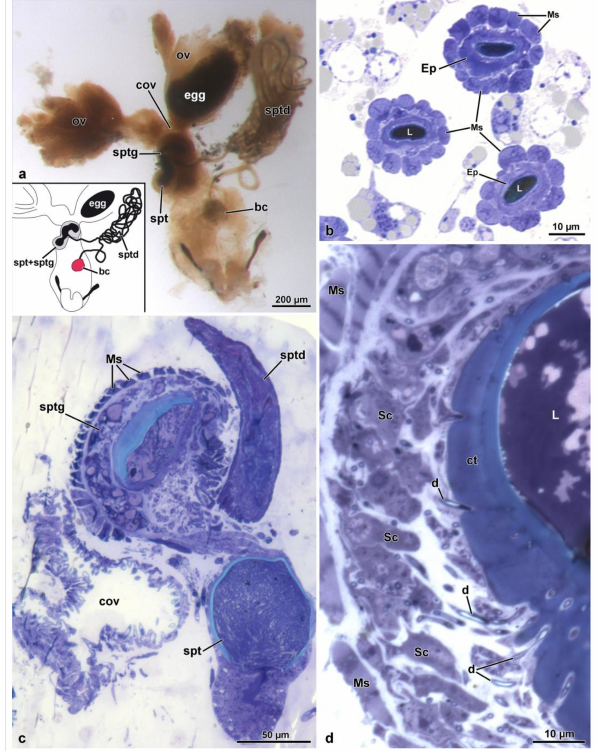
Figure 1. ( a ). Light microscopic view of the female reproductive organs. bc, bursa copulatrix; cov, common oviduct; ov, oviduct; spt, spermatheca; sptd, spermathecal duct; sptg, spermathecal gland. Egg at the end of the oviduct. ( b ). Semi-thin section through the spermathecal duct showing the thick layer of muscle cells (Ms) and the epithelium (Ep). L, duct lumen. ( c ). Semi-thin section of the complex spermatheca (spt)–spermathecal gland (sptg). Note the spermathecal duct (sptd) and the common oviduct (cov). ( d ). Semi-thin section of the spermathecal gland epithelia (Ep) showing the outer muscle layer (Ms), the secretory cells (Sc), the ducts (d) of the duct-forming cells, the thick cuticle (ct) and the gland lumen